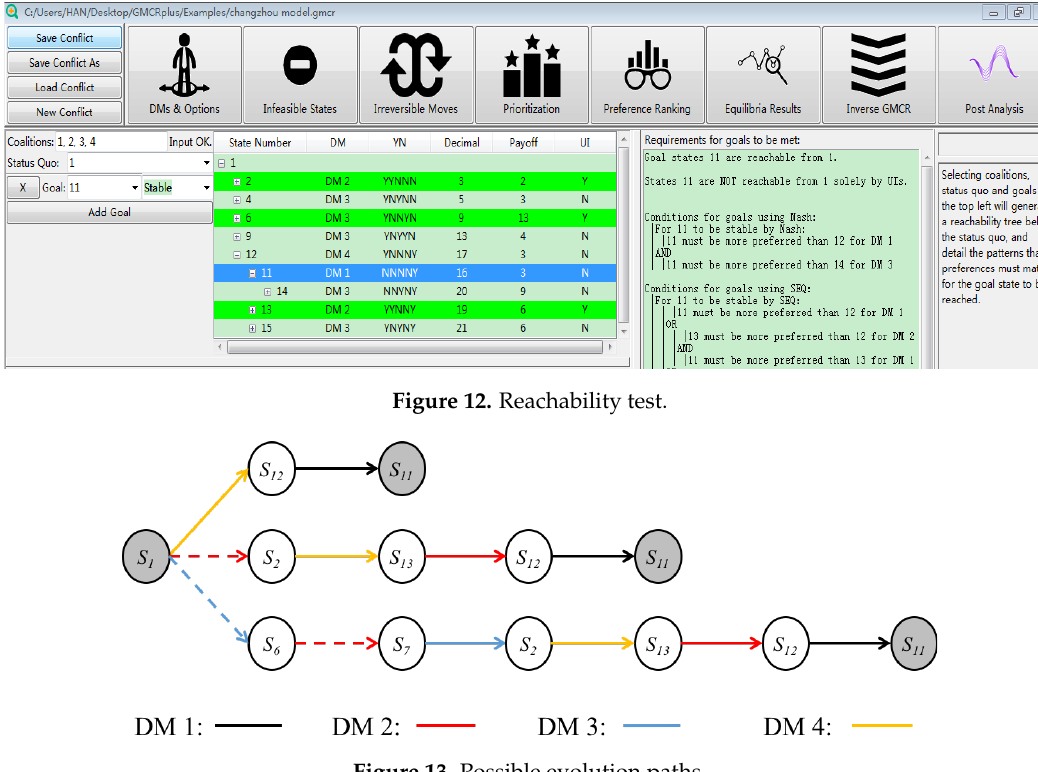
Figure 13. Possible evolution paths.